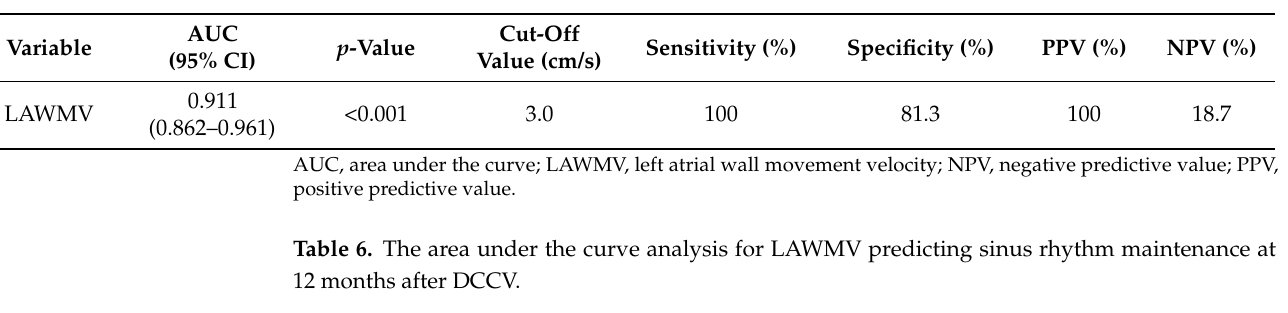
Table 5. The area under the curve analysis for LAWMV predicting sinus rhythm restoration after DCCV.